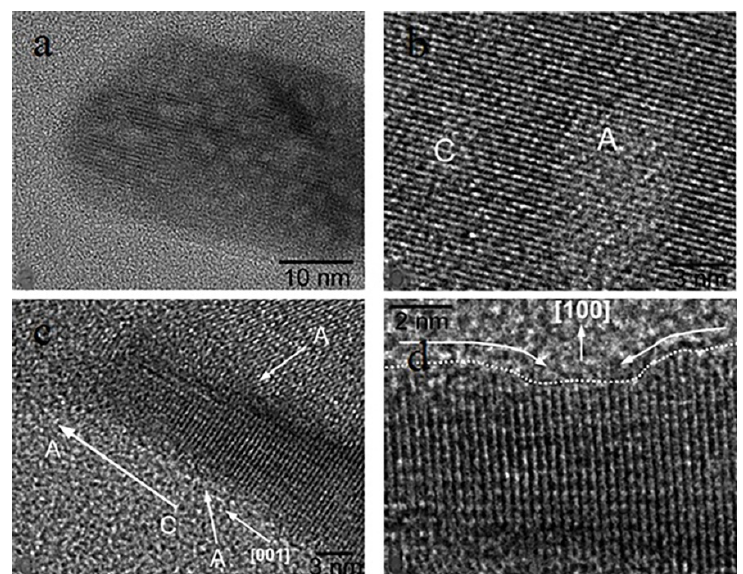
Figure 8. TEM images: ( a ) amorphous spherical units attached to grow rod-shaped HAp nanoparticles; ( b ) the interface between amorphous spheroid unit and nanoparticle; ( c ) [001] crystallographic direction and the amorphous coating around the crystalline particle interior; and ( d ) steps formed at the growth front of an HAp nanoparticle in the ( a ). Arrows in ( c ) indicate the growth direction. The figure is reproduced with copyright permission of ref. [67].